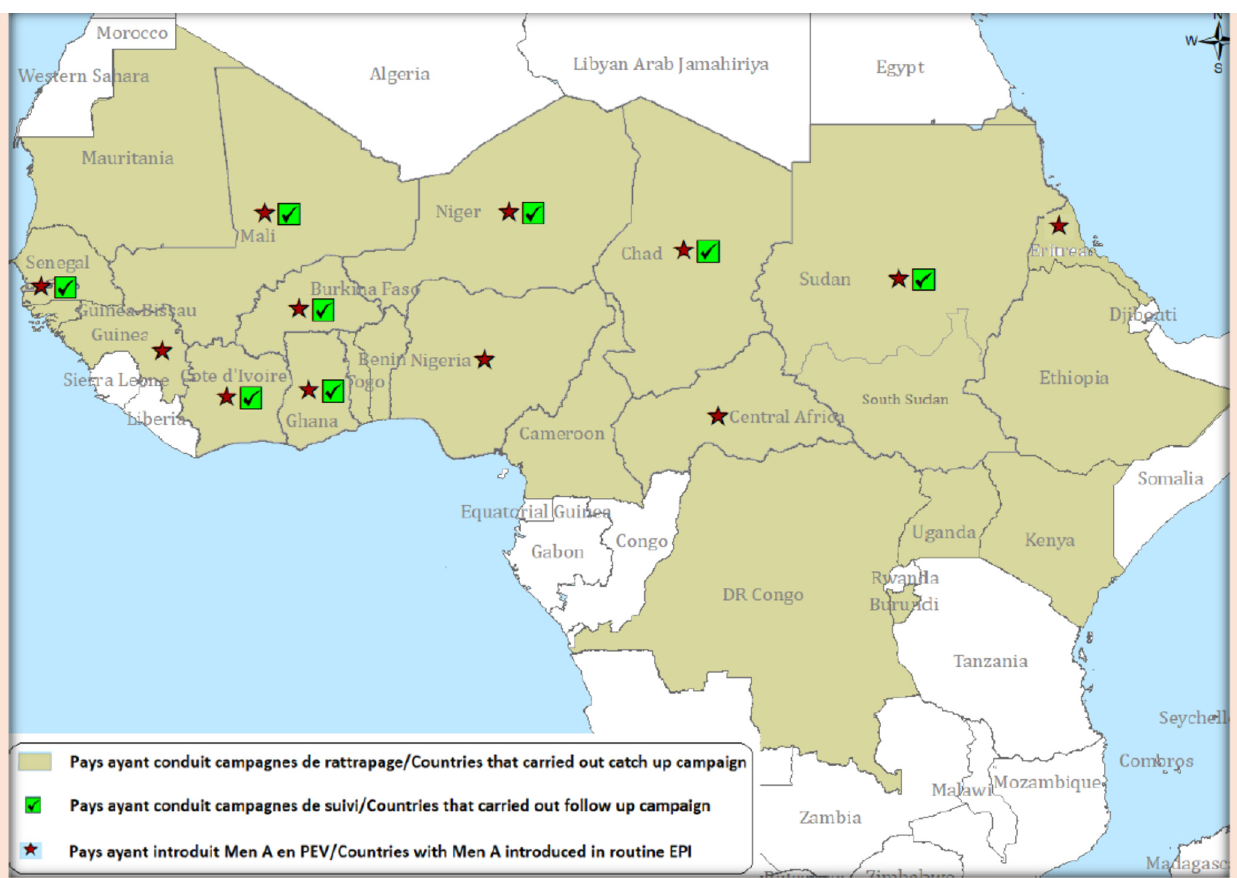
Figure 2. MenAfriVac ® introduction in the meningitis belt countries, 2010–2021. From WHO/IST-WA Meningitis Weekly Bulletin, 2021 (https://cdn.who.int/media/docs/default-source/2021-dha-docs/bulletin-meningite_s26_2021.pdf?sfvrsn=3512cc8e_1&download=true) (accessed 22 March 2022) .